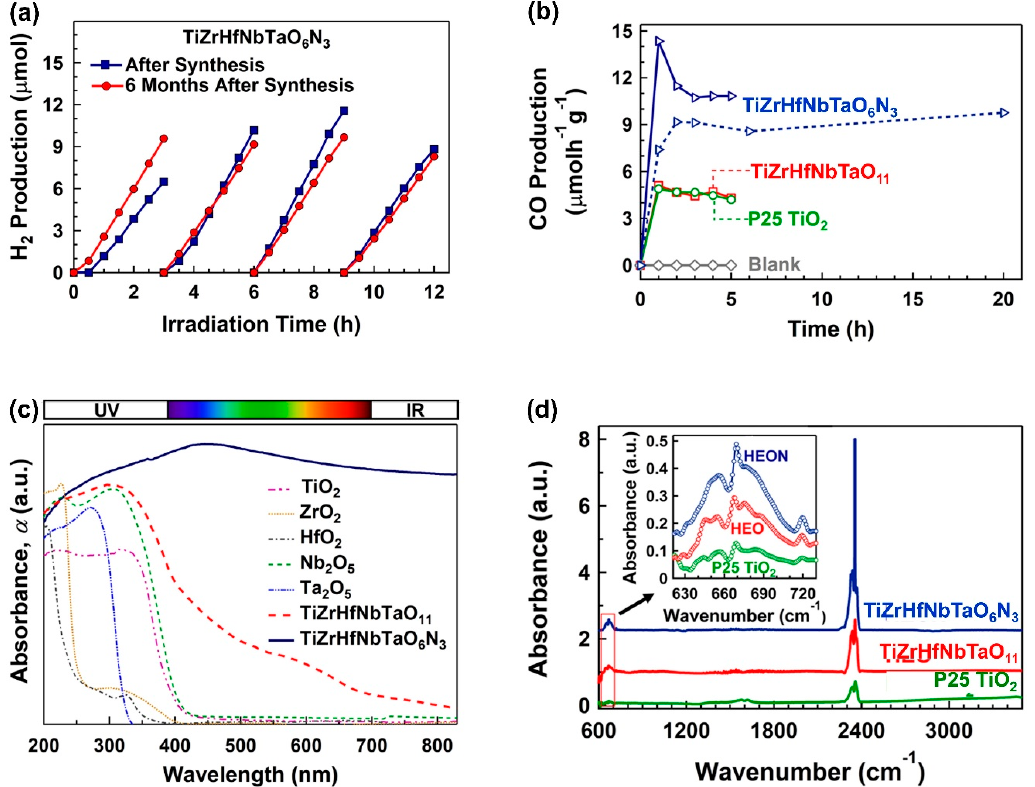
Figure 8. Application ultra-SPD for developing high-entropy oxides and oxynitrides as a new family of photocatalysts for photocatalytic hydrogen production and CO 2 conversion. ( a ) Photocatalytic hydrogen production versus light irradiation time on TiZrHfNbTaO 3 N 6 synthesized by ultra-SPD [58]. ( b ) Photocatalytic CO 2 to CO conversion versus light irradiation time on TiZrHfNbTaO 11 and TiZrHfNbTaO 3 N 6 synthesized by ultra-SPD in comparison with P25 TiO 2 benchmark photocatalyst [60]. ( c ) Light absorbance in TiZrHfNbTaO 11 and TiZrHfNbTaO 3 N 6 in comparison with binary oxides [58]. ( d ) Diffuse reflectance infrared Fourier transform spectra for TiZrHfNbTaO 11 and TiZrHfNbTaO 3 N 6 in comparison with P25 TiO 2 where intensities of spectra at 665 cm − 1 and 2350 cm − 1 represent chemisorption and physisorption of CO 2 on catalyst surface [60].